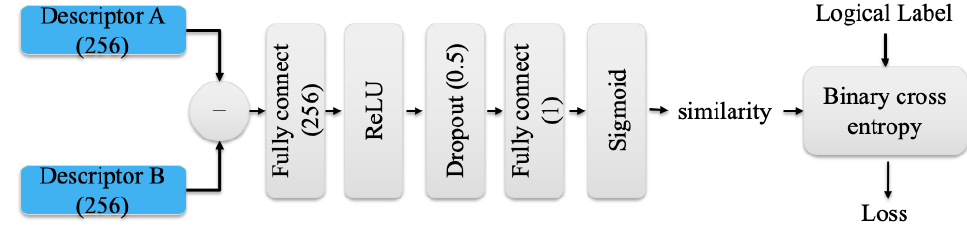
Figure 3. Network architecture of CNN classification model